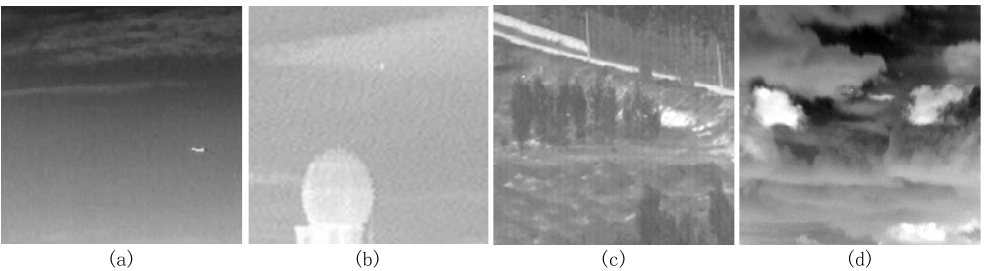
Figure 1. Samples of simple and complex scenes. ( a , b ) Simple scenes. ( c , d ) Complex scenes used in our experiments.